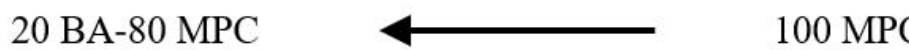
Figure 3. The pictures of specimens for different mix proportions.